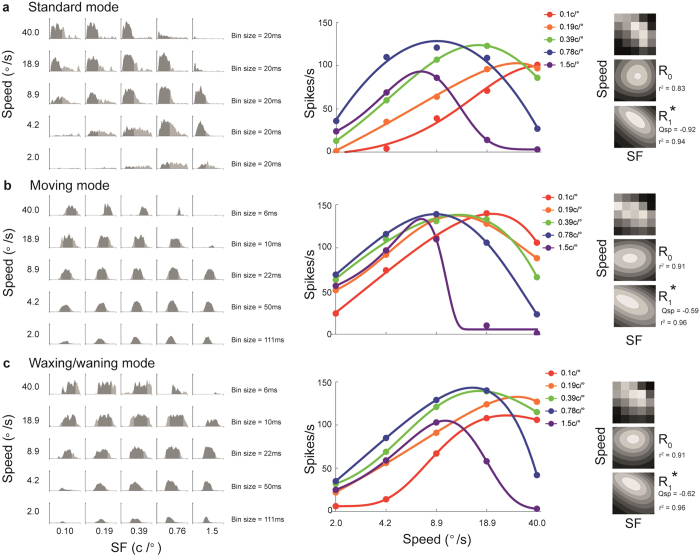
Data from a MT neuron that was not speed-tuned in all three modes.The data are presented in the same format as in Fig. 3. The y-axis in all PSTHs uses the same scale (maximum 192 Hz).